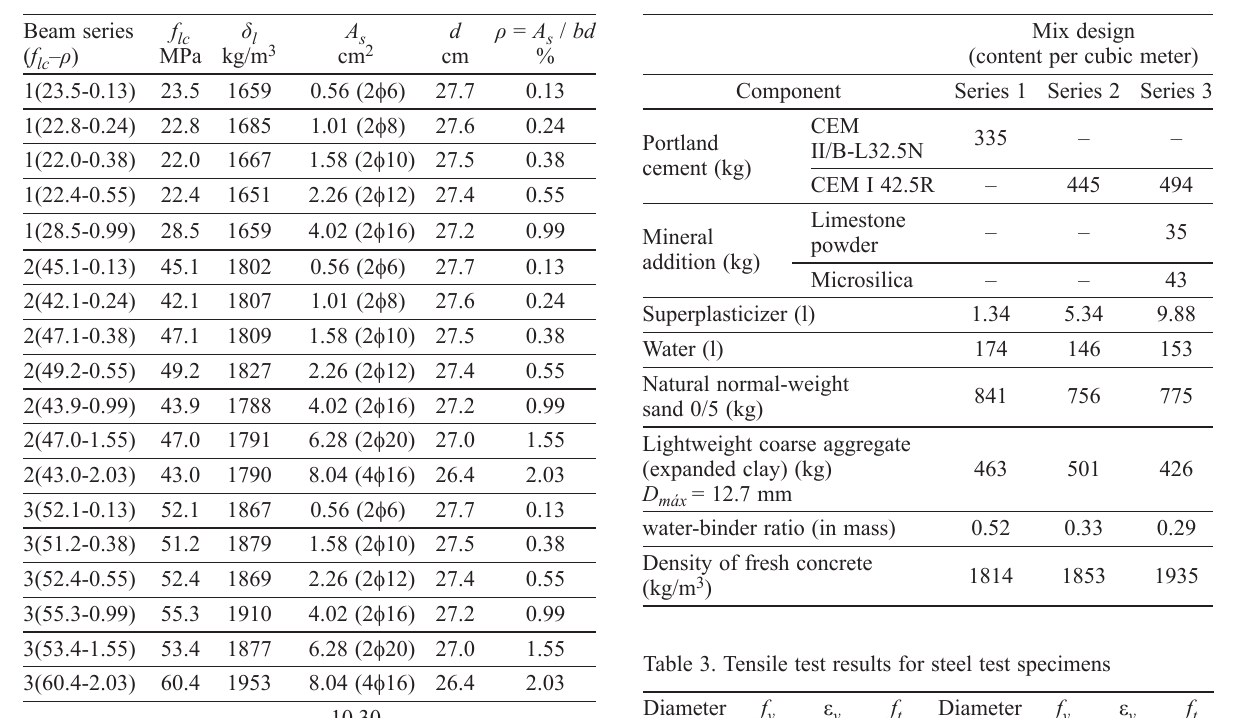
Table 1. Properties of test beams Table 2. Mix design of LWAC